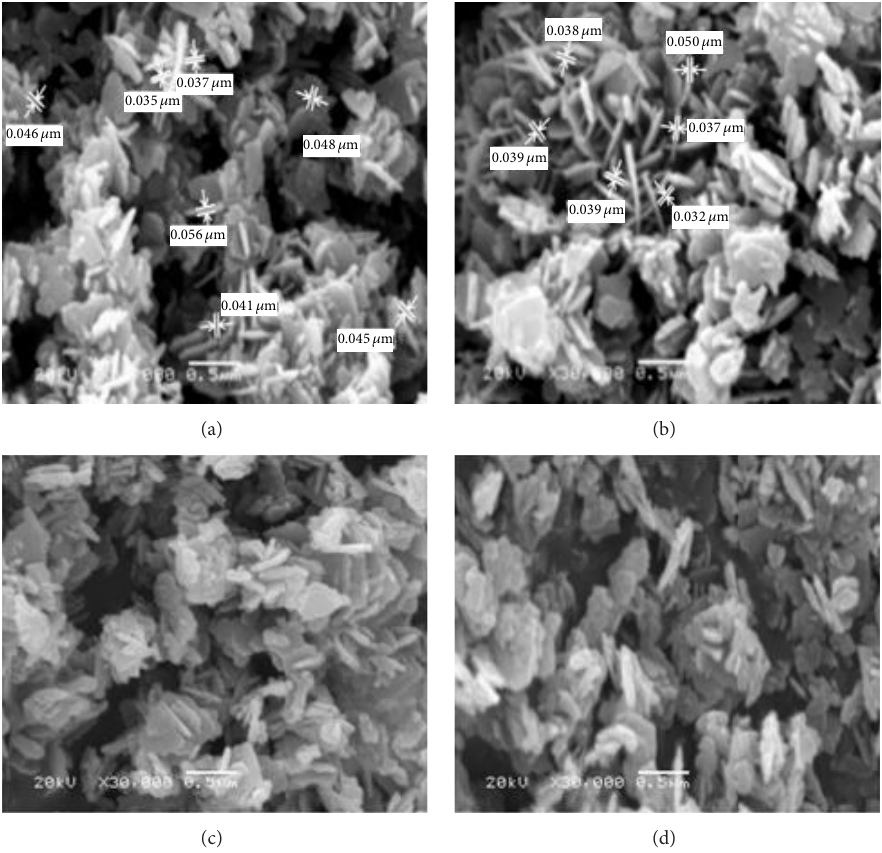
Figure 12: SEM micrographs of ZnO prepared using hydrothermal technique at different reaction temperatures: (a) 60 ∘ C, (b) 70 ∘ C, (c) 80 ∘ C, and (d) 90 ∘